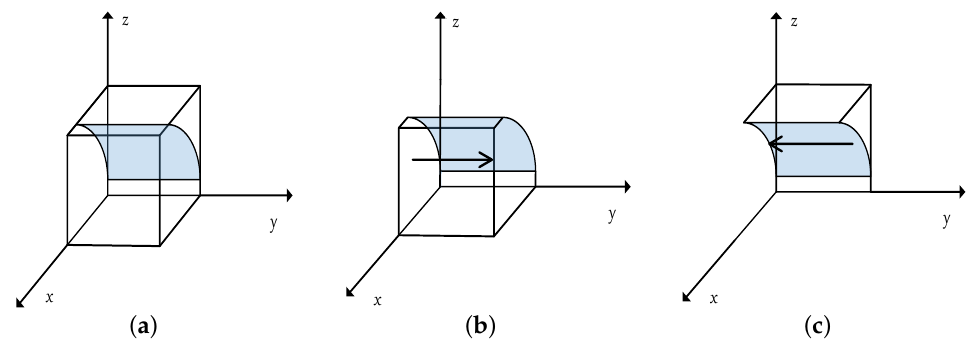
Figure 3. Replication dynamic phase diagram of crowdsourcing platforms: ( a ) z = z 0 ; ( b ) z < z 0 ; ( c ) z > z 0